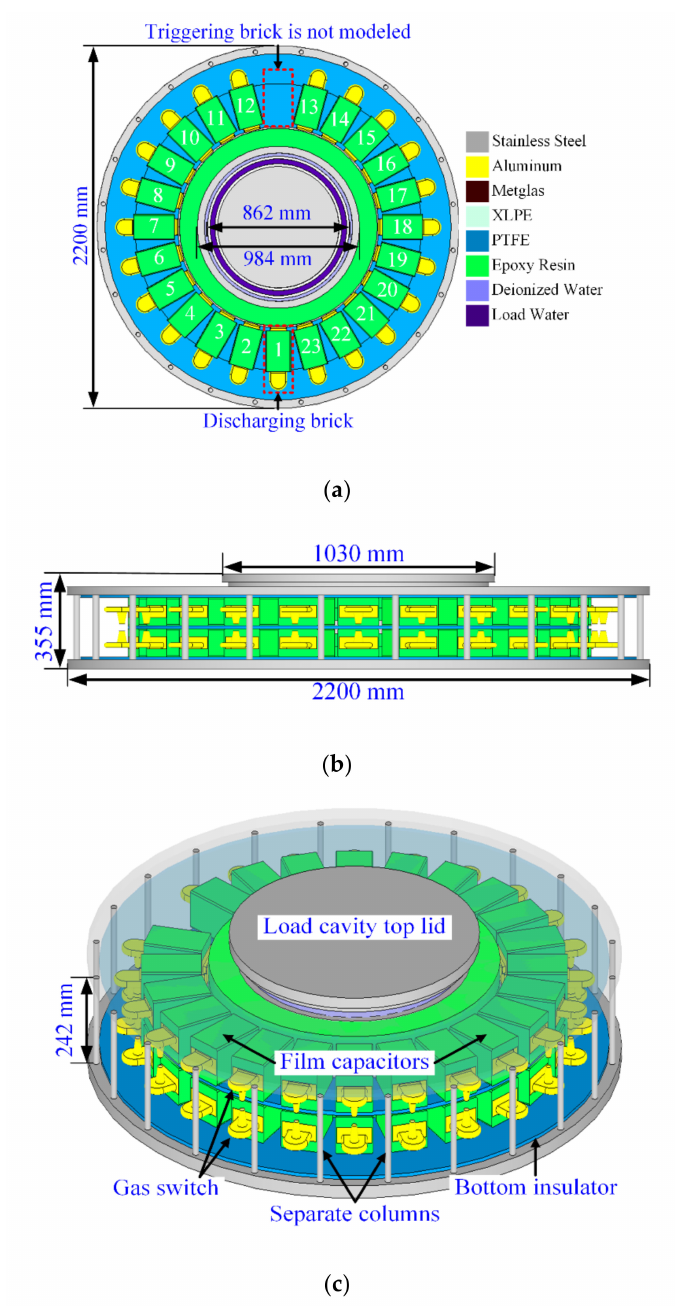
Figure 5. Numerical model of the single-stage FLTD with 24-separate columns. ( a ) Top view with cavity top lid and insulator removed, ( b ) side view, and ( c ) axonometric view with cavity top lid and insulator set to be